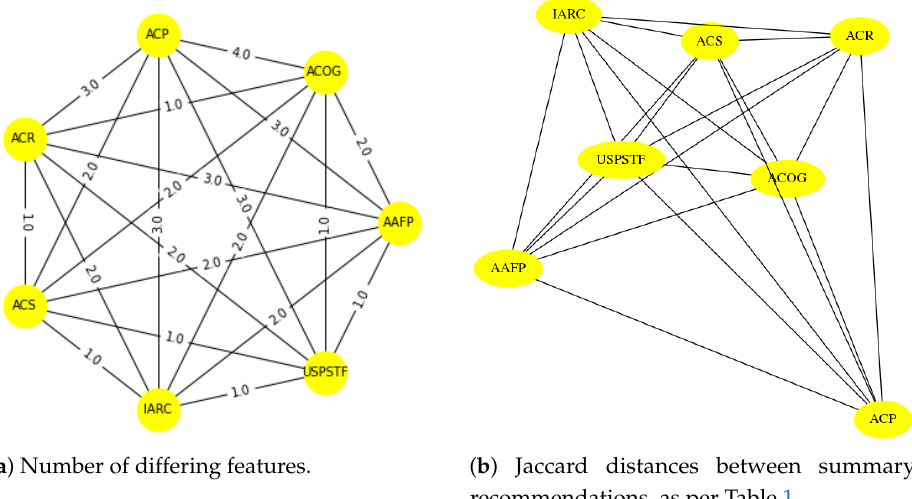
( a ) Number of differing features. ( b ) Jaccard distances between summary recommendations, as per Table 1. Figure 4. In panel ( a ) we see a pictorial representation of the numbers of differing features, per Tables 2 and 3. These differences between recommendations are converted into distances (using the Jaccard measure), resulting in panel ( b ). Can we replicate the geometric structure of panel ( b ) using automated tools? See Section 6 for an